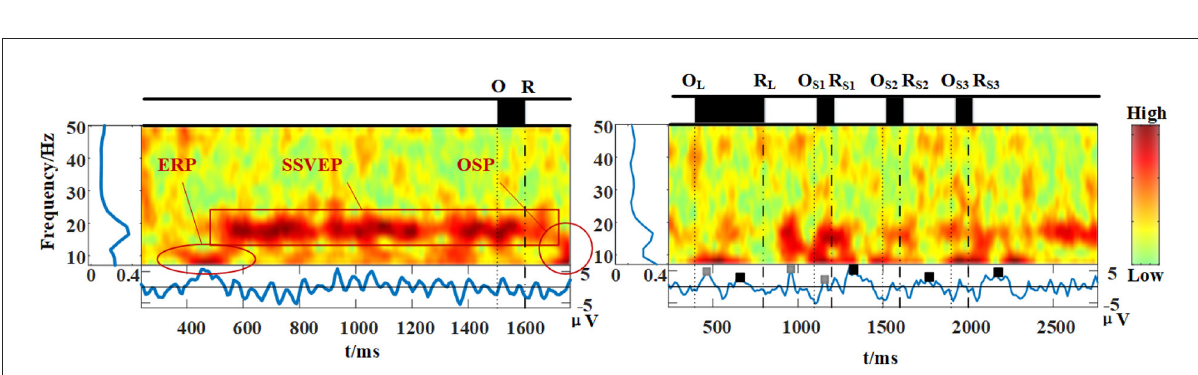
FIGURE11 Time-frequency analysis at POz for left: one-time omission and for right: four-times omission including one long omission and three short omissions (64 trials). The stimulation frequency is 15Hz.